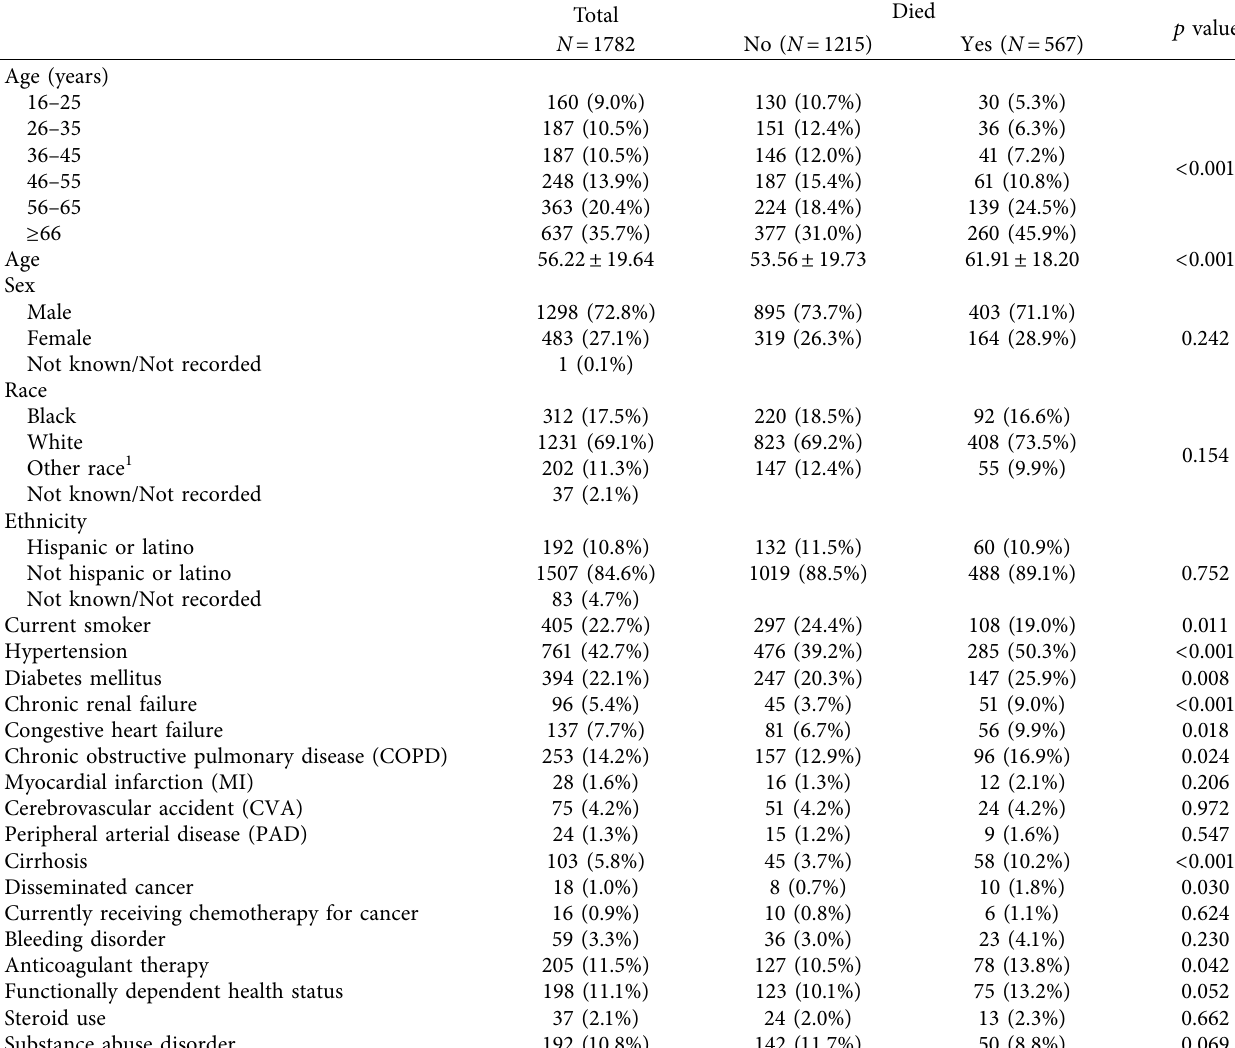
Table 1: Table showing the baseline characteristics of the trauma patients who developed sepsis during their hospital